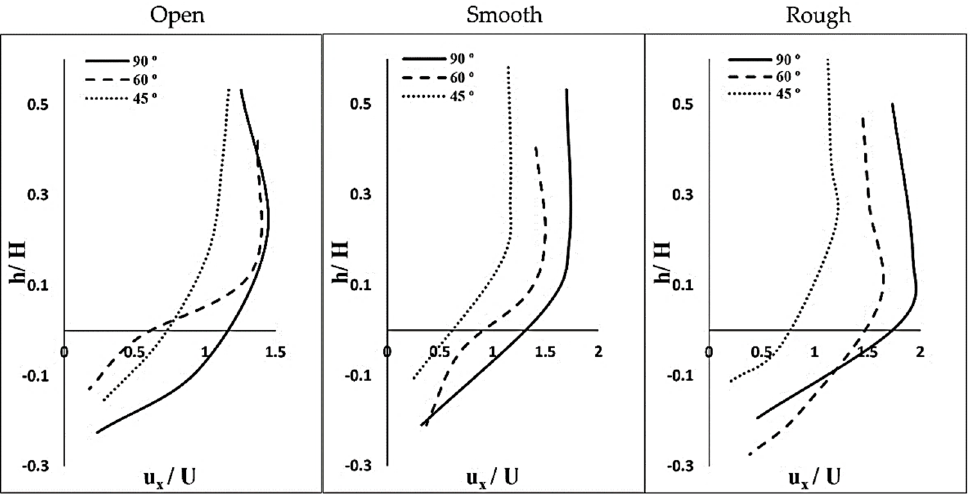
Figure 9. Streamwise velocity profile (u x ) inside and outside the scour holes for different dike orientation angles (water depth: 31 cm). ADV measurements subject to +/- 0.25 cm/s error.